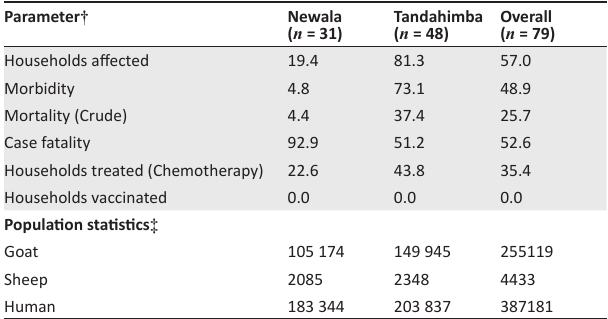
FIGURE 1: Showing sampling points and introduction of Peste des Petits Ruminants in Newala (star). TABLE 1: The proportions of households, morbidity, mortality, chemotherapy, vaccination and statistics for goats, sheep and people.